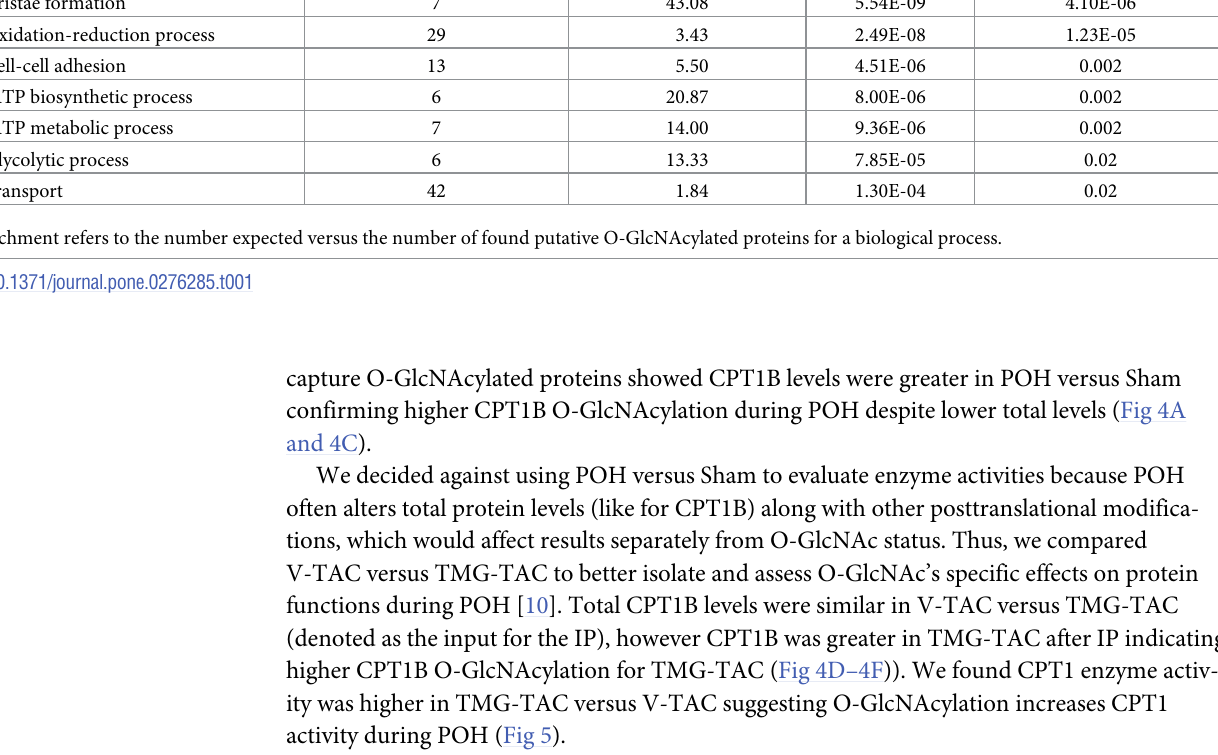
Table 2. KEGG pathways with significant overexpression for putative O-GlcNAcylated protein changes during pressure overload hypertrophy (POH).